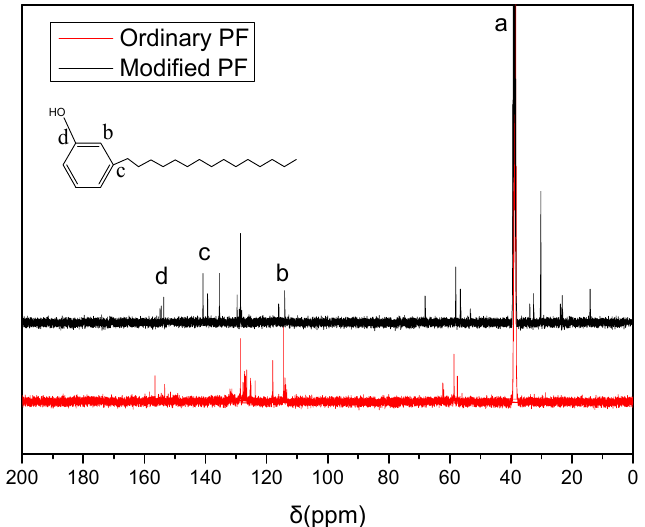
Figure 3. The 13 C NMR spectra of the ordinary PF and modified PF (the amount of 3-pentadecyl-phenol is 15% of the total amount of phenol).